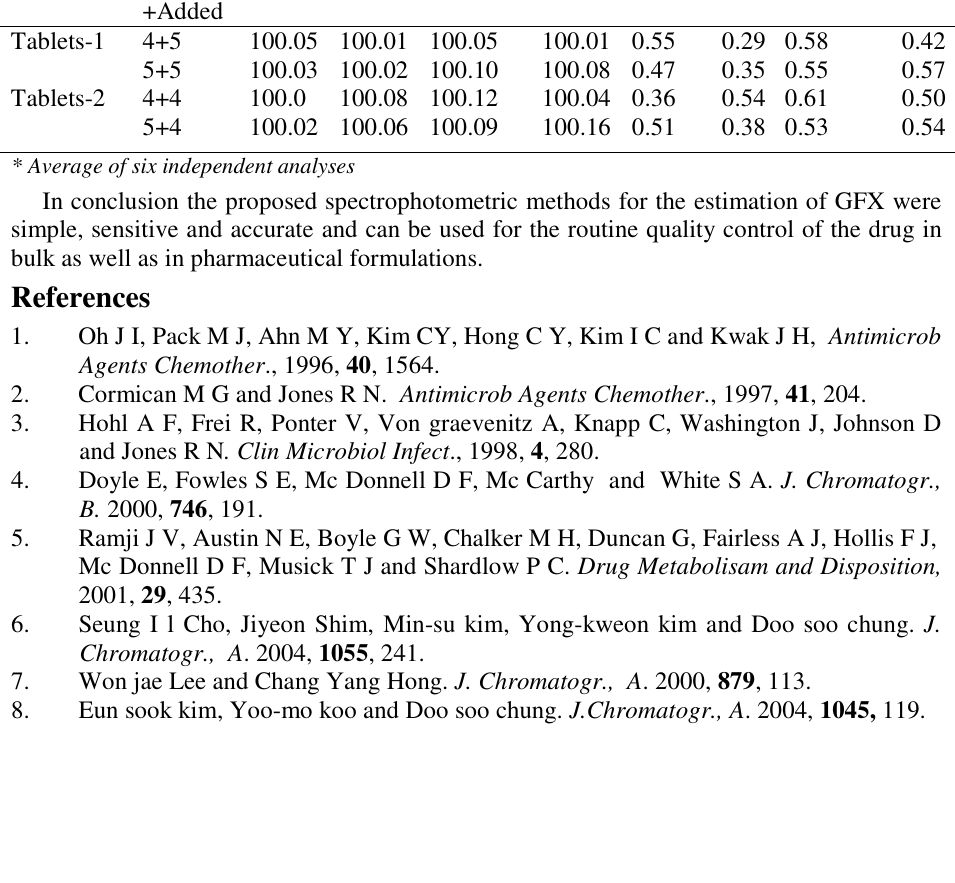
Table 5. Results of recovery study by standard addition method